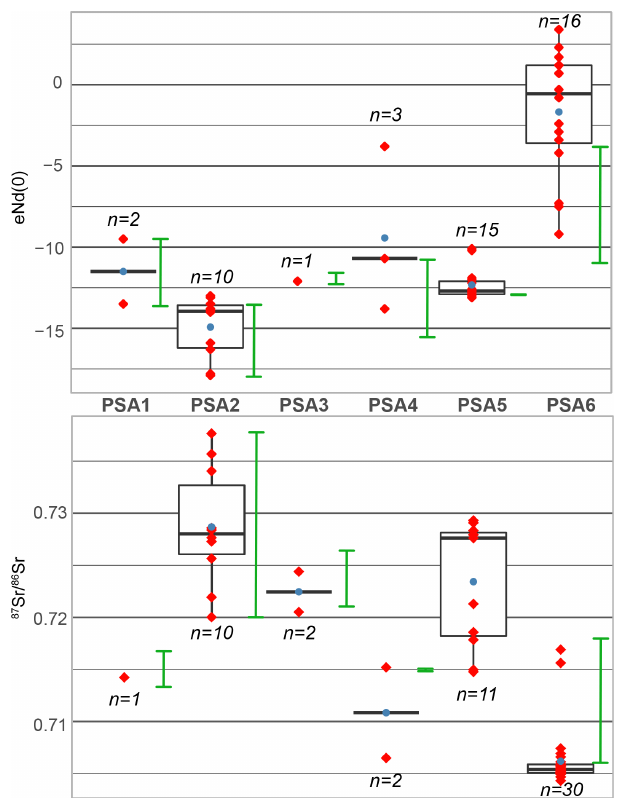
Figure 4. Box and whiskers plot for the isotopic signatures of African PSAs. After identifying samples that are located in each PSA (see Table 3 and Fig. 1), the range and skewness of datasets in the PSA were analysed using box and whiskers plots (when sample number n was higher than 5) and compared to the isotopic ranges reported by Scheuvens et al. (2013) (green bars). Data points are shown as red diamonds and the arithmetical mean is provided (blue dots). The rectangles indicate the upper and lower quartiles and the median is shown as a thicker horizontal line (Krzywinski and Alt- man,